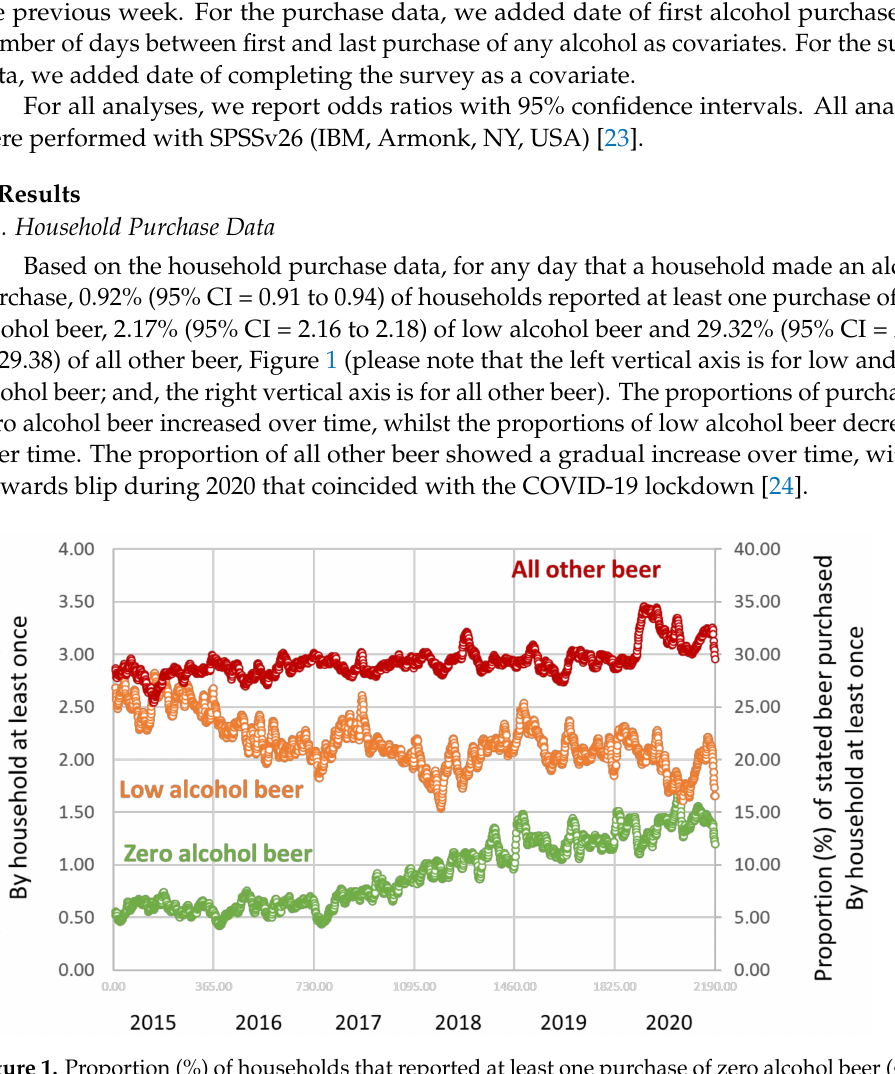
Figure 1. Proportion (%) of households that reported at least one purchase of zero alcohol beer (green, left vertical axis), low alcohol beer (orange, left vertical axis) and all other beer (red, right vertical axis) for any day that a household made an alcohol purchase by study day, 2015 to 2020. Data points: